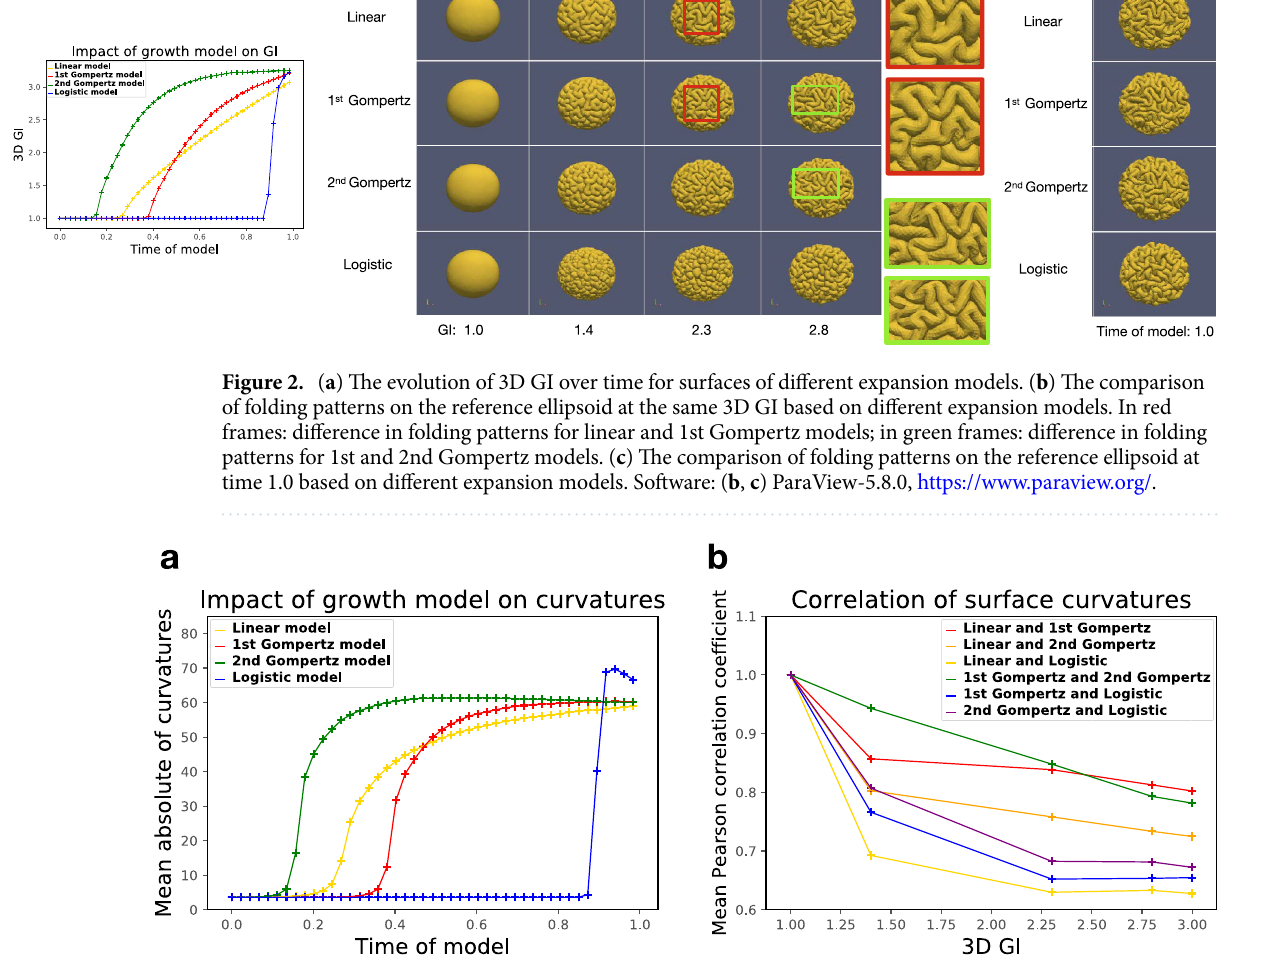
Figure 3. The comparison of ( a ), average of absolute value of dimensionless mean curvatures and ( b ), mean Pearson correlation coefficients of mean curvatures for surfaces based on different expansion For angular uniformity calculations, P corresponds to the fold angular distribution on the folded surface, Q represents the theoretically uniform distribution of fold angles. Results